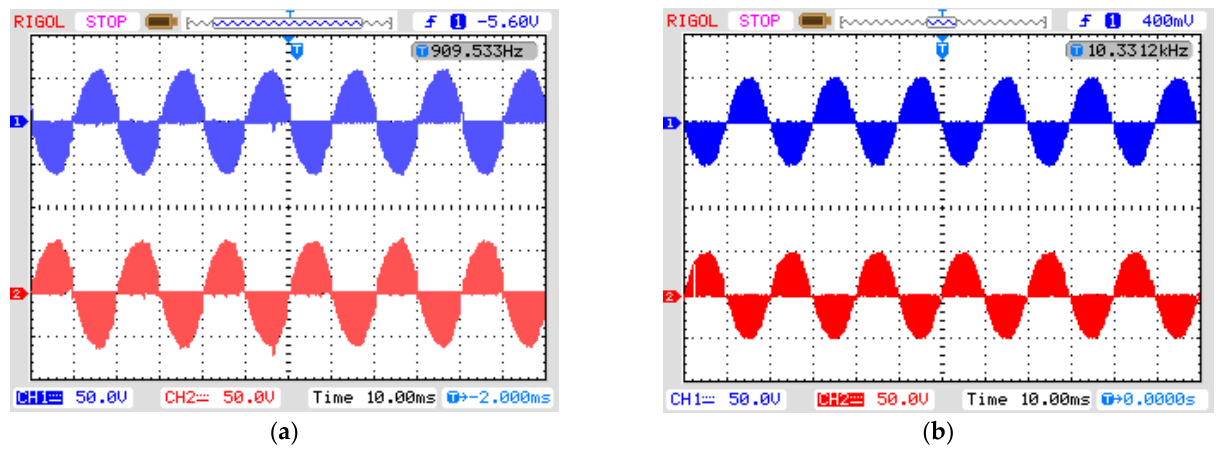
Figure 17. Practically obtained results for output step-up process across T r 5 , D 5 (blue) and T r 6 , D 6 (red) in ( a ) non-inverted form and ( b ) inverted form.